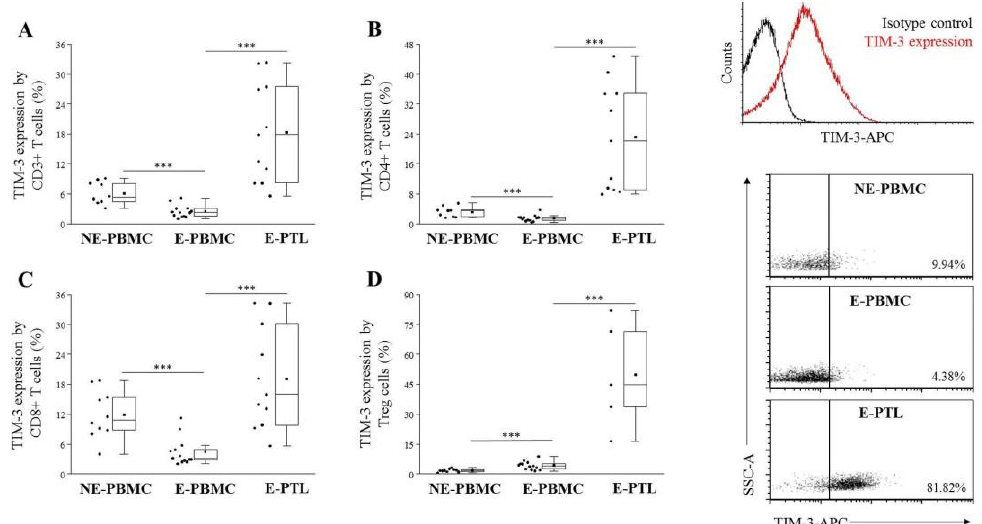
Figure 3. Comparison of the TIM-3 receptor expression by peripheral (PBMC) and peritoneal (PTL) CD3 + T ( A ), CD4 + T ( B ), CD8 + T ( C ) and Treg ( D ) cell subpopulations in non-endometriotic (NE) women and patients with endometriosis (E). Left: the solid bars represent medians of 10, 12, and 11 determinations; the boxes show the interquartile ranges, and the whiskers show the most extreme observations. The middle square within the box represents the mean value. Statistically significant di ff erences with p -values of *** < 0.01 are indicated. Right: representative histograms and dot plots showing TIM-3 receptor expression by T cells in NE-PBMC, E-PBMC and E-PTL samples.